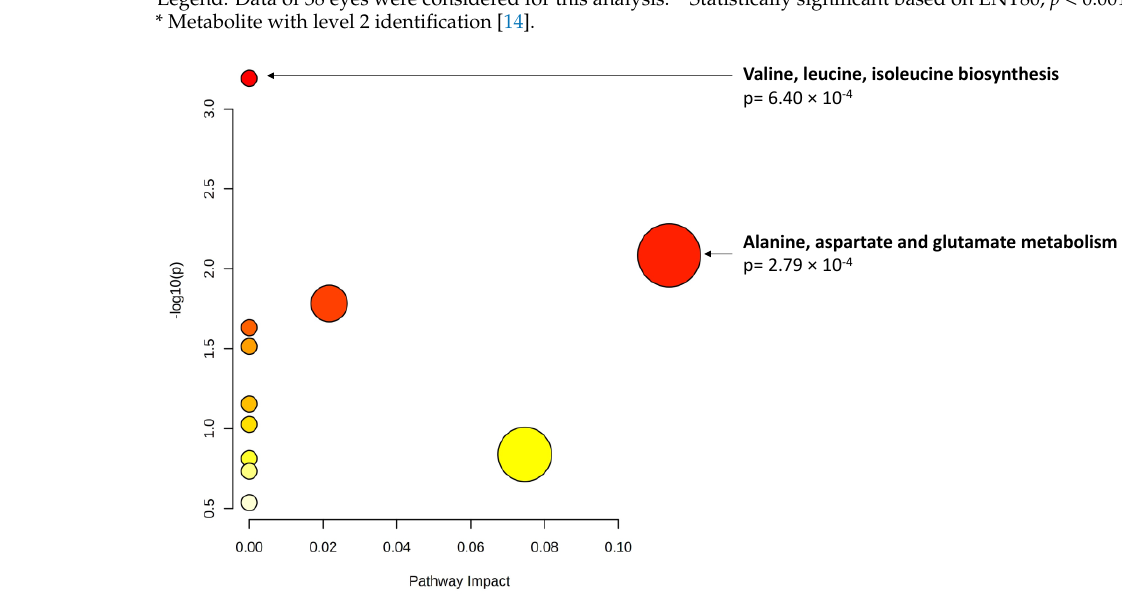
Figure 2. Pathway analysis of metabolite changes ( p < 0.01) associated with area under the dark adaptation curve (AUDAC) changes at 3 years. X axis: pathway impact, calculated as the sum of the importance measures of the matched metabolites normalized by the sum of the importance measures of all metabolites in each pathway. Y axis: − log(p): logarithm of the p -value, based on the hypergeometric pathway enrichment test. The color and size of each circle are based on its p -value and pathway impact value, respectively. Namely, colors vary from white to red from less significant to most significant p -values.